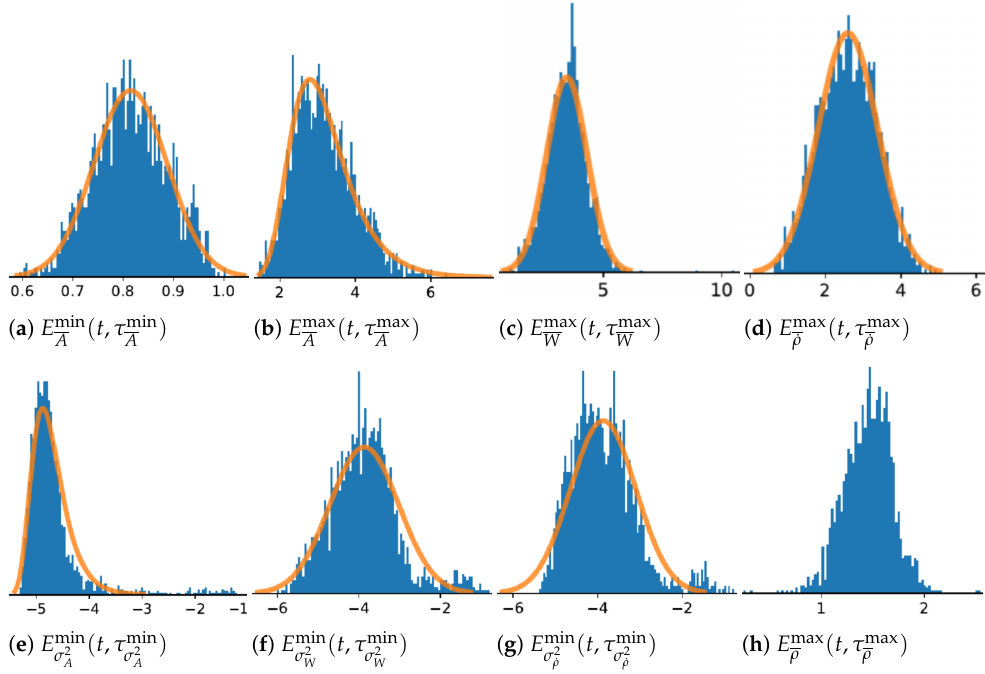
Figure 2. Distributions of extreme values